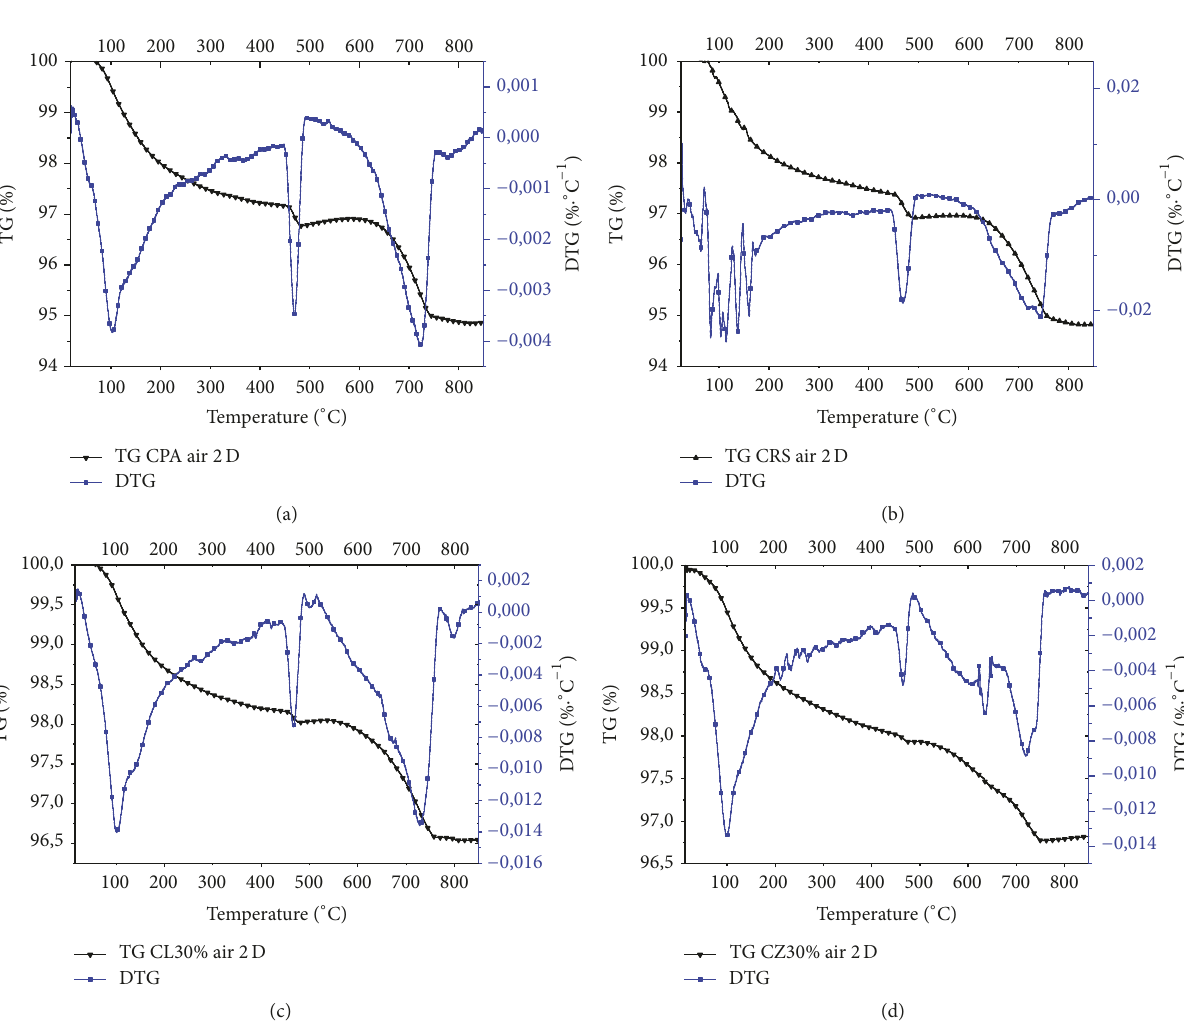
Figure 4: DTG/TG cement paste preserved on air (RH = 65%, 𝑇 = 20 ∘ C) for 2 days. (a) CPA/(b) CRS/(c) CL30% (30% slag)/(d) CZ3% (30%